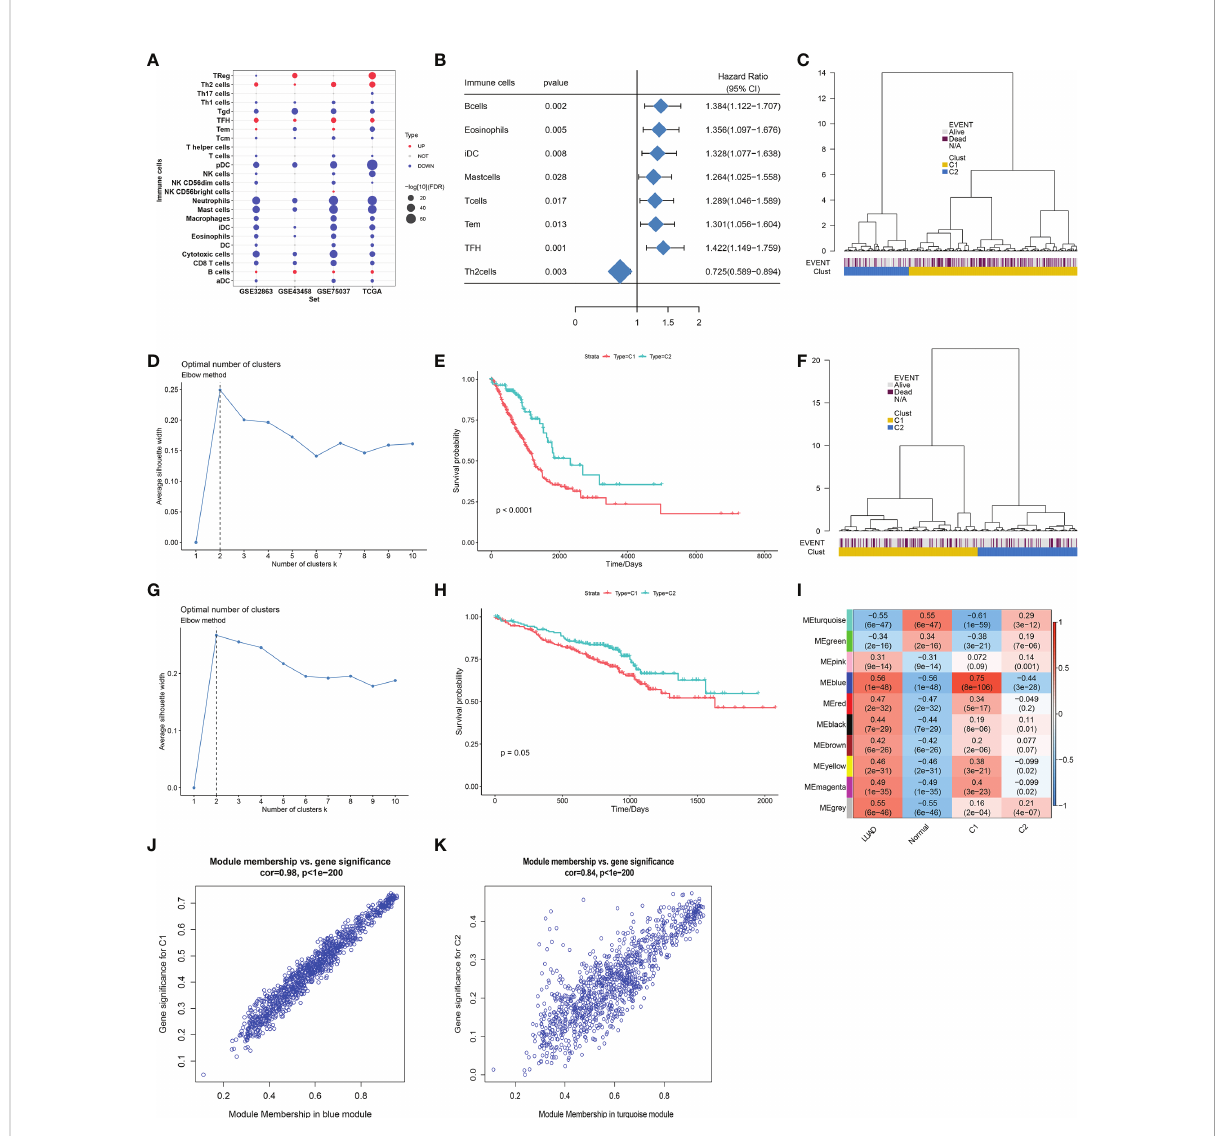
FIGURE 2 De fi nition of immune cell in fi ltration-based classi fi cation across LUAD. (A) Differences in in fi ltration levels of immune cell types between LUAD and normal lung tissues in four datasets (GSE32863, GSE43458, GSE75037, and TCGA-LUAD). (B) Forest plot of immune cell types whose in fi ltration levels signi fi cantly correlated to TCGA-LUAD cases ’ OS. (C) De fi nition of two molecular subtypes across TCGA-LUAD on the basis of in fi ltration levels of seven risky immune cell types. (D) Elbow method for validating the accuracy of this molecular classi fi cation across TCGA- LUAD samples. (E) Kaplan – Meier curves of OS between two subtypes in TCGA-LUAD cohort. (F) Validation of this immune cell in fi ltration-based classi fi cation in the GSE72094 cohort. (G) Elbow method for validating the optimal number of clusters in the GSE72094 cohort. (H) Kaplan – Meier curves of OS between two subtypes in the GSE72094 cohort. (I) Heatmap of the associations between co-expression modules and clinical traits (LUAD and normal tissues; C1 and C2 subtypes). (J) Scatter plots of the correlation between module membership in MEblue module and gene signi fi cance for C1 subtype. (K) The correlation between module membership in MEturquoise module and gene signi fi cance for C2 subtype. LUAD, lung adenocarcinoma; OS, overall